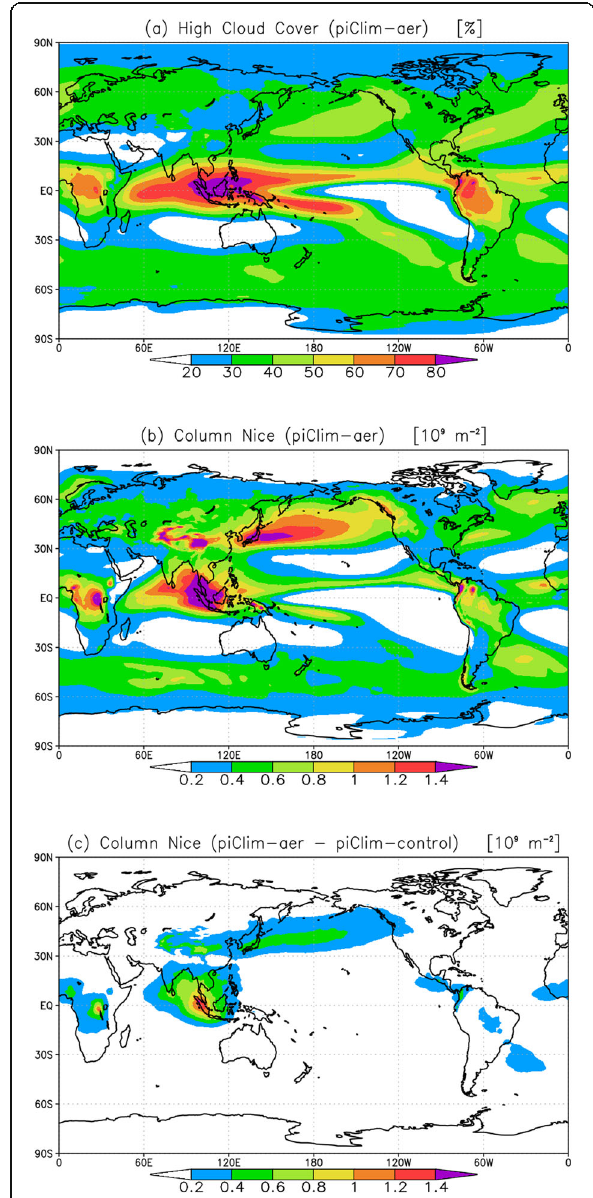
Fig. 7 Horizontal distributions of the 30-year annual mean ( a ) high- level (above 440-hPa level) cloud cover (%) and ( b ) column- integrated number concentration of ice crystals (10 9 m − 2 ) in the piClim-aer experiment and ( c ) the difference in the column- integrated number concentration of ice crystals between the piClim- aer and piClim-control experiments (10 9 m − 2